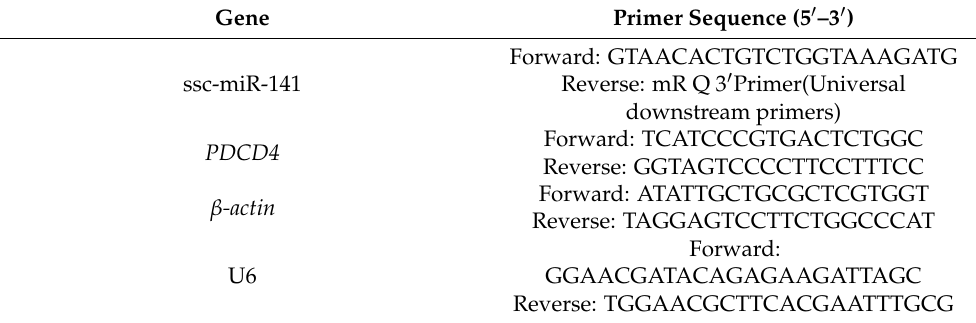
Table 1. Primer information for qPCR.